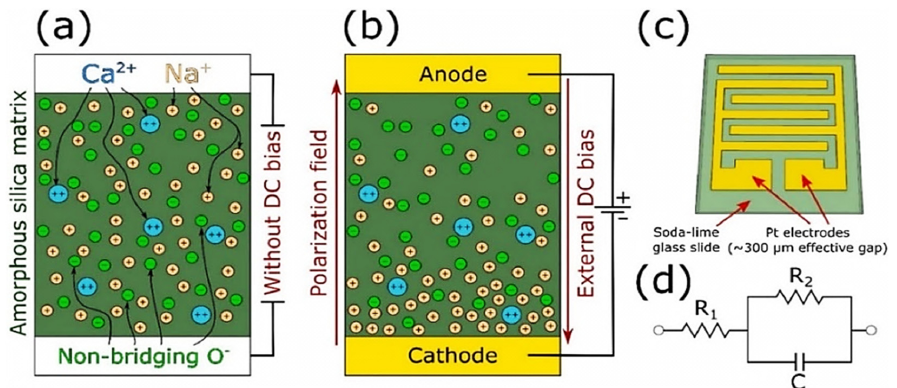
Figure 35. Schematic of the structures of ( a ) unbiased and ( b ) DC-biased soda-lime glass, ( c ) testing device design, and ( d ) the corresponding structure of an electrochemical cell (Randles circuit). Reproduced from [156] with the permission of Elsevier.